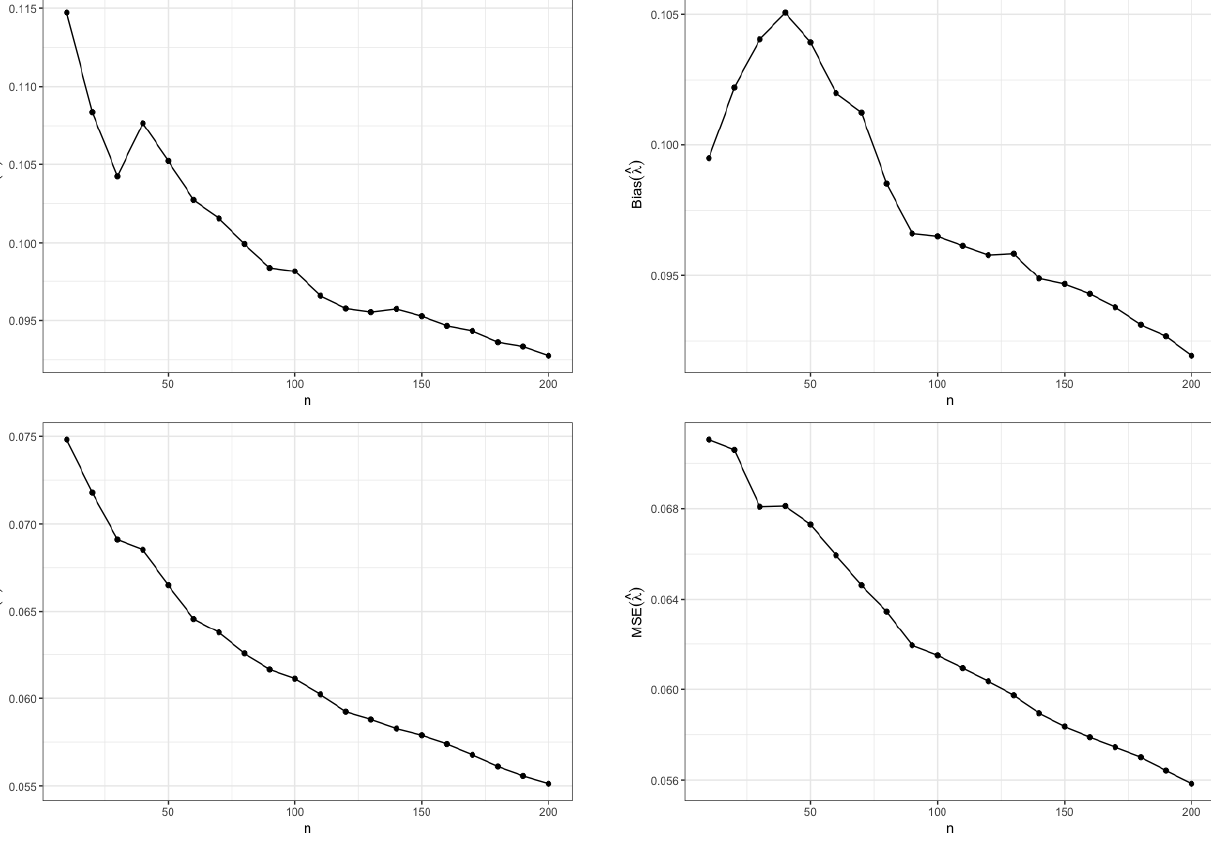
Figure 3. Bias and MSE for λ = 0.5 ( left ) and λ = 2 ( right ).